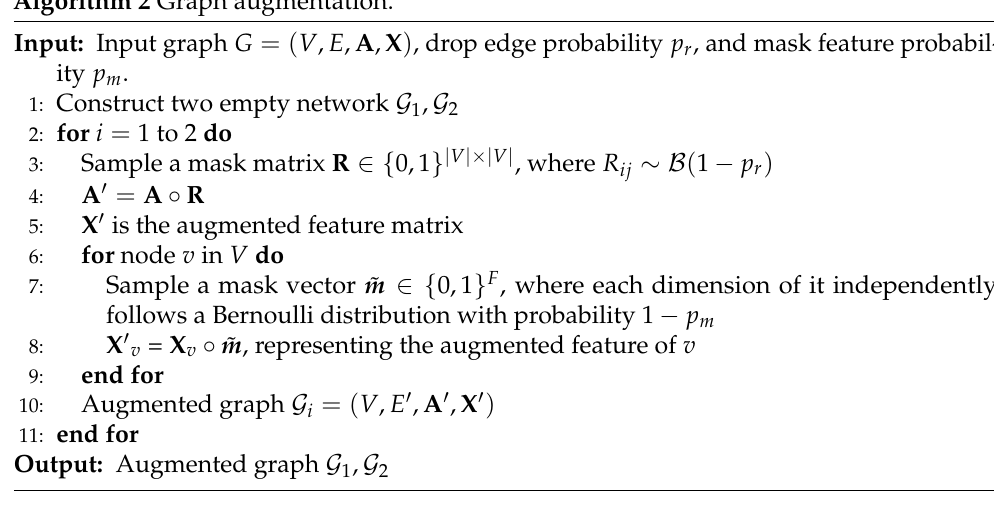
Algorithm 2 Graph